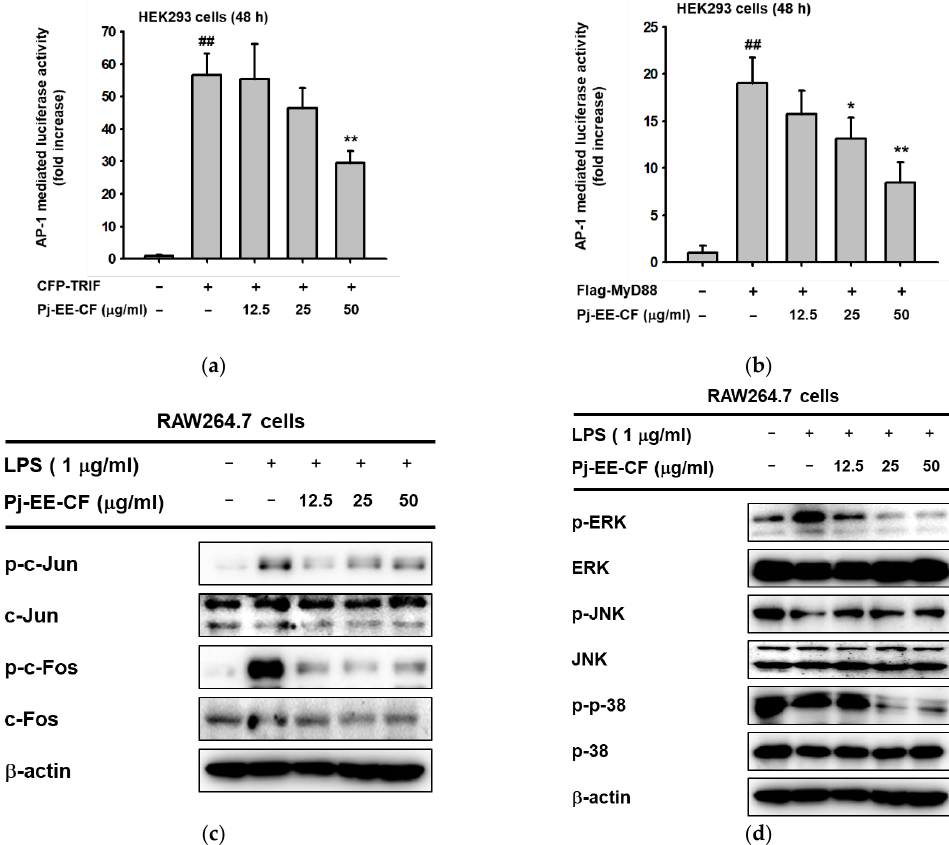
Figure 3. Effect of Pj-EE-CF on the transcriptional activation of AP-1 signaling and the upstream signaling molecules of AP-1 activation. ( a , b ) HEK293 cells were co-transfected with AP-1-Luc and β-gal (0.8 μg), as well as TRIF and MyD88 for 48 h in the presence or absence of Pj-EE-CF (12.5, 25, and 50 μg/mL), which were then examined using a luminometer. Results are expressed as mean ± standard deviation ( n = 4). ## p < 0.01 compared to normal group, * p < 0.05 and ** p < 0.01 compared to control group (LPS alone) by one-way ANOVA. ( c ) The phospho- and total forms of AP-1 subunits, c-Jun and c-Fos, from whole-cell lysates from LPS-treated RAW264.7 cells in the presence or absence of Pj-EE-CF (12.5, 25, and 50 μg/mL) were determined by immunoblot analysis. ( d ) RAW264.7 cells were pretreated with Pj-EE-CF (12.5, 25, and 50 μg/mL) for 30 min, followed by the presence or absence of LPS. The phosphorylated and total protein levels of ERK, JNK, and p38 were assessed by immunoblot analysis. β-actin was utilized as a control protein.